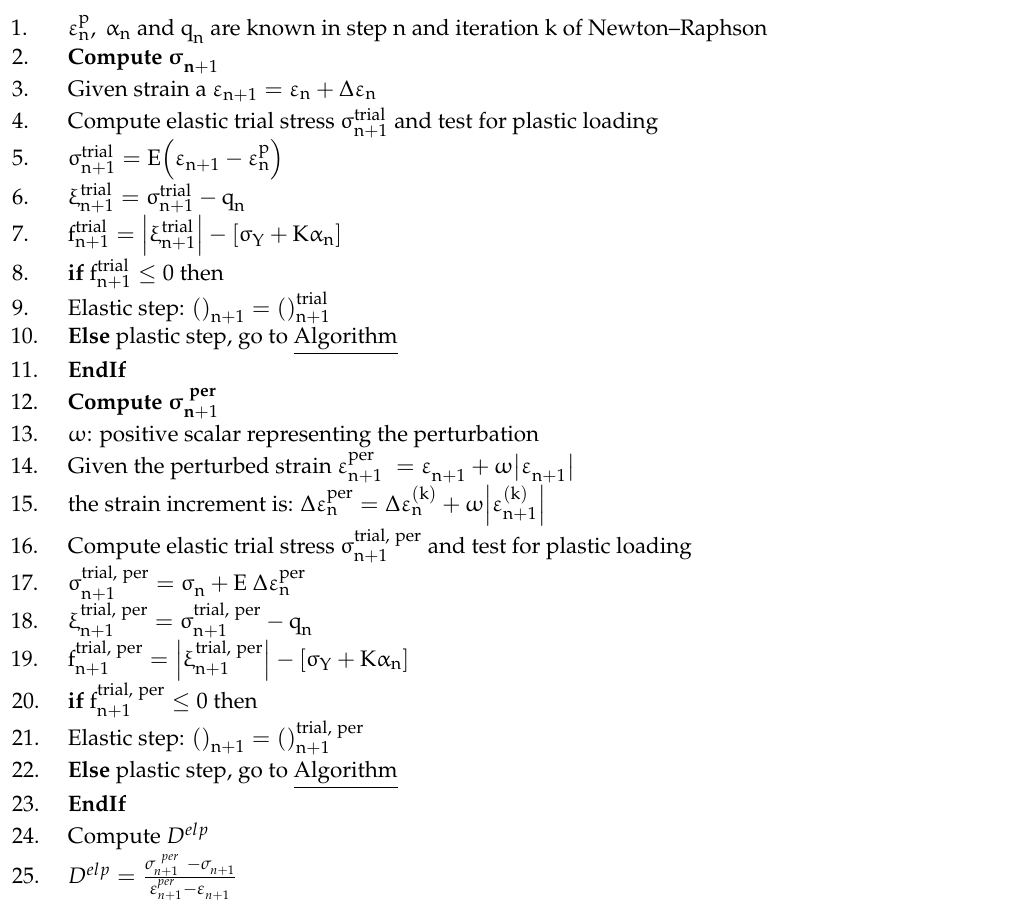
Algorithm 7 : Numerical computation of the elastoplastic tangent